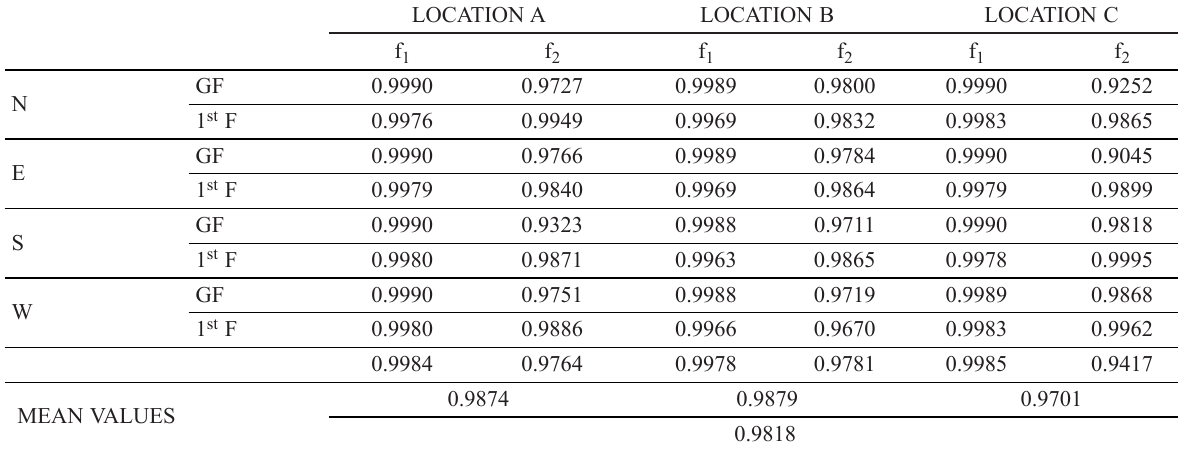
Table 2. ANN R 2 for model